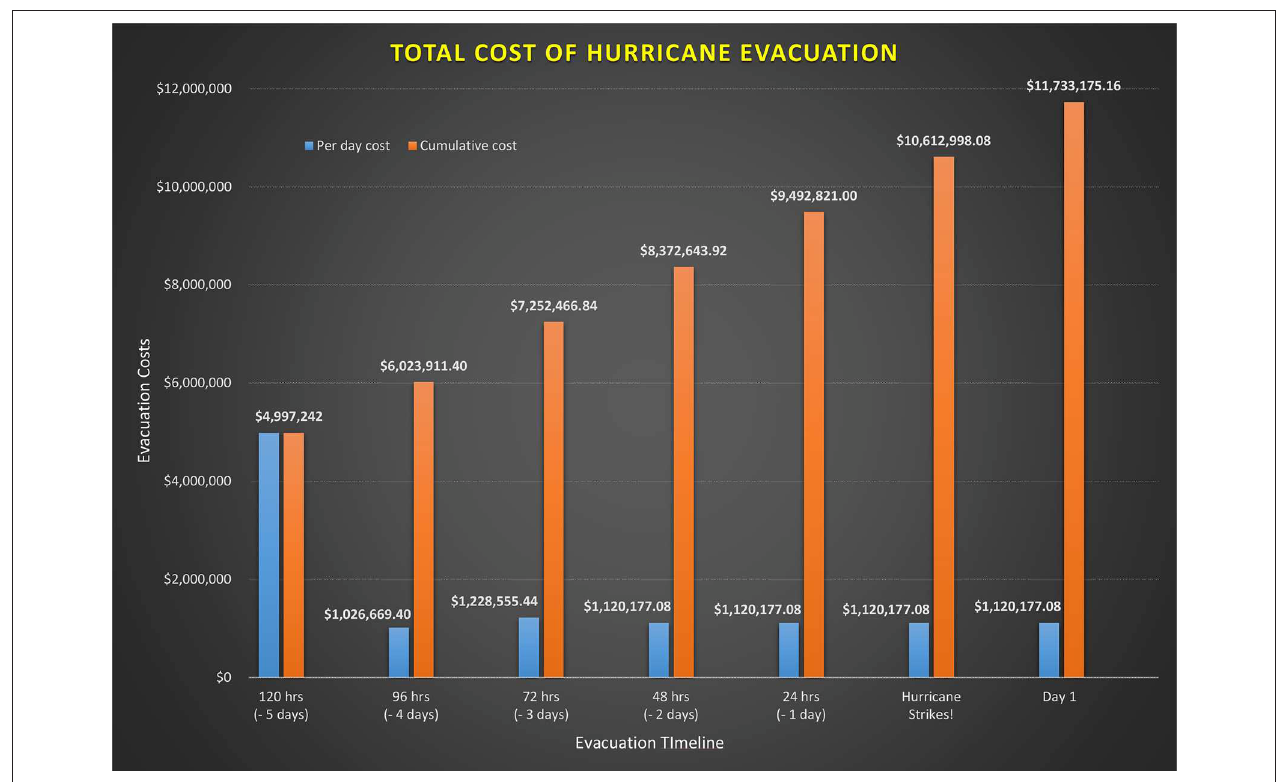
FIGURE 1 | Cumulative costs of hurricane evacuation by